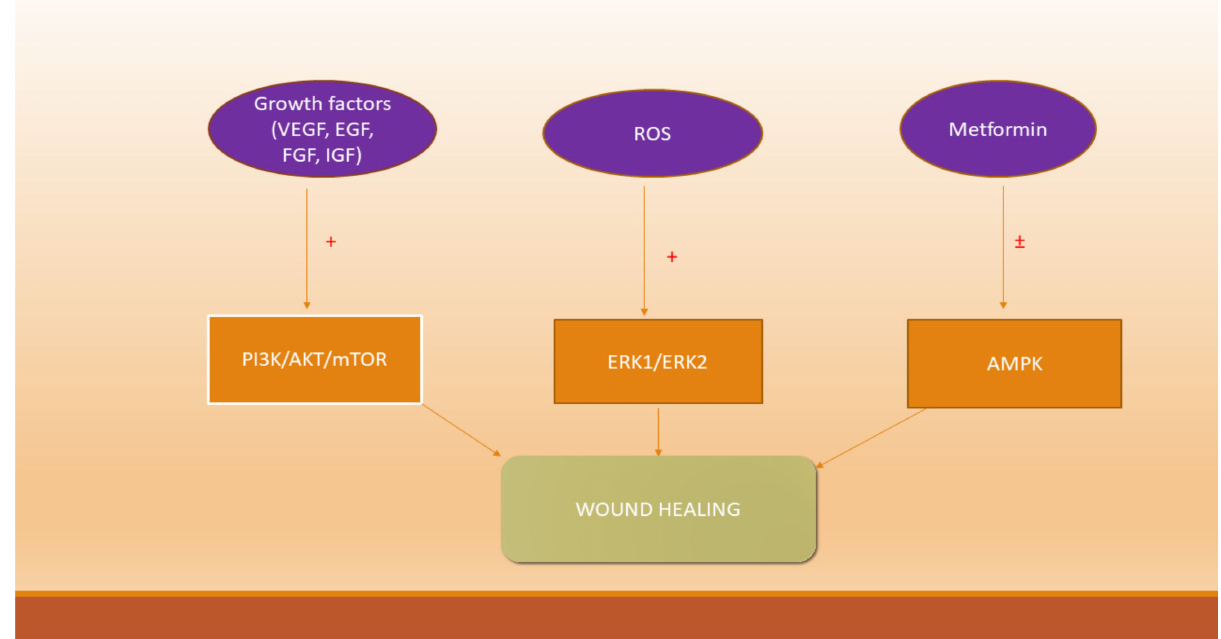
Figure 2. Growth factors, reactive oxygen species, metformin, and signaling pathways involved in the wound healing process (+ activation, −